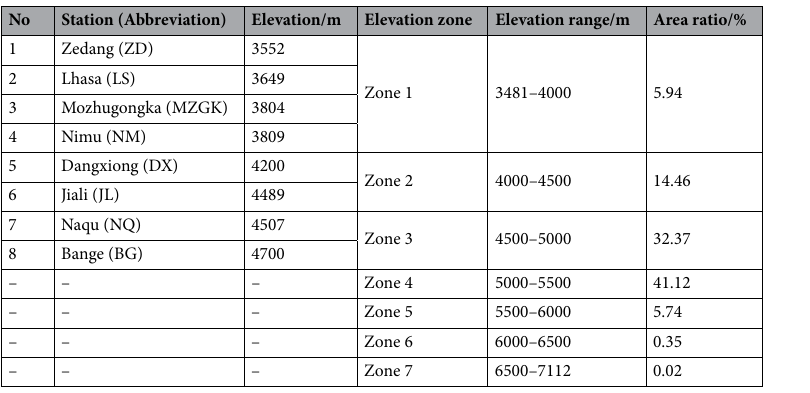
Table 1. Detail information of the elevation zones and MET stations in the